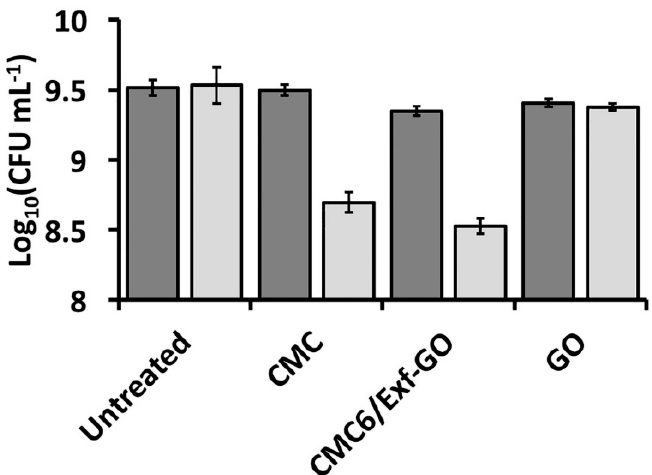
Figure 7. Bar graph reporting the biomass yield of both P. aeruginosa ATCC ® 10145 ™ (dark grey bar) and S. aureus ATCC ® 25923 ™ (light grey bar).